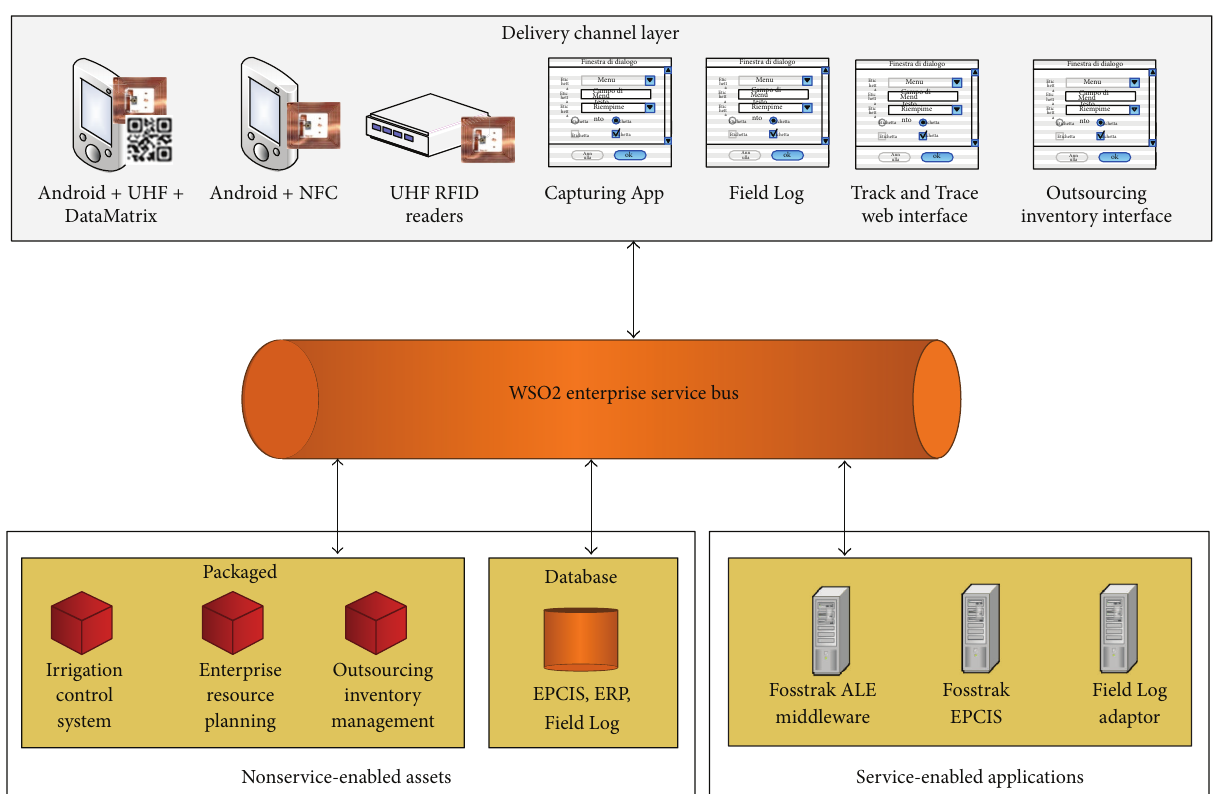
Figure 8: The overall system